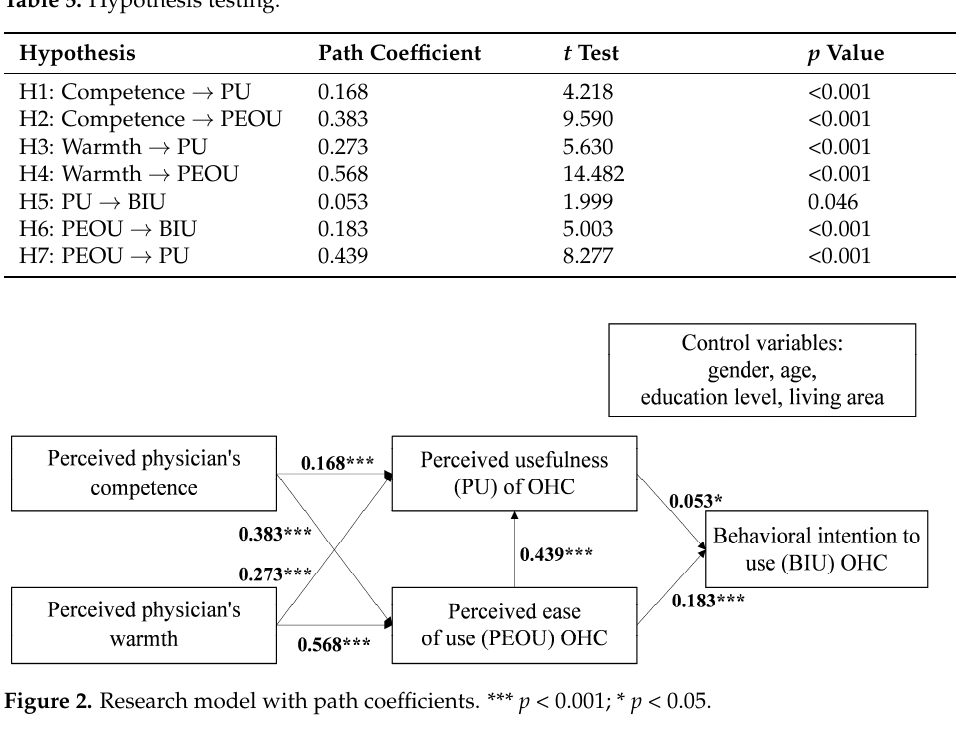
Table 6. Path coefficients by bootstrapping.